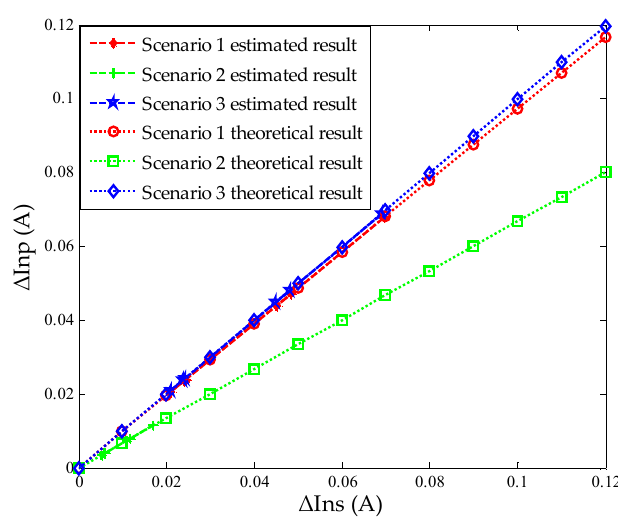
Figure 8. Results comparison for parameter g under three different scenarios.